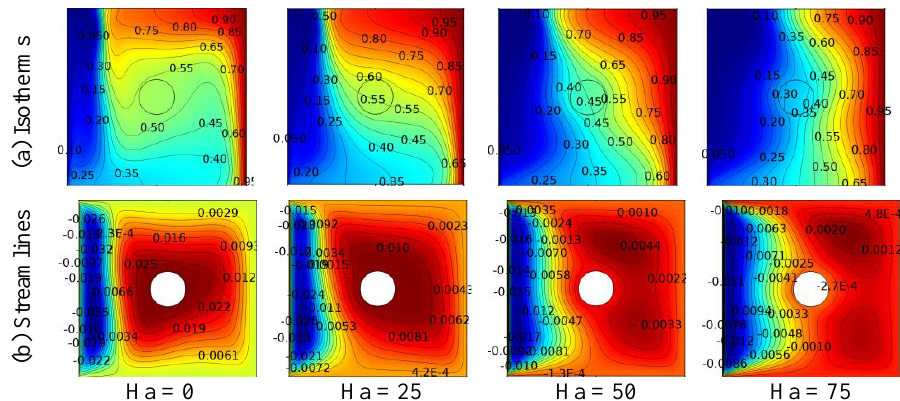
Fig. 4. isotherms (a) and Streamlines(b) for different values of Ha, with Ri = 3, φ = 0.04 and J=0.